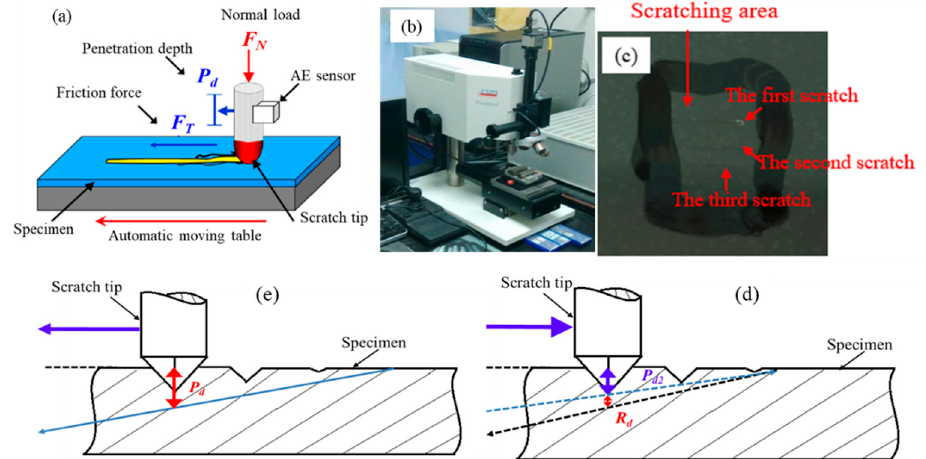
Figure 2. Experimental method: ( a ) schematic; ( b ) scratching experiment setup (CSM Revetest Scratch Tester); ( c ) scratching area; ( d ) schematic diagram of the curve P d (the penetration depth of the tip); ( e ) schematic diagram of the curve R d (the difference between P d and residual depth of the scratch track) and mean elastic recovery.